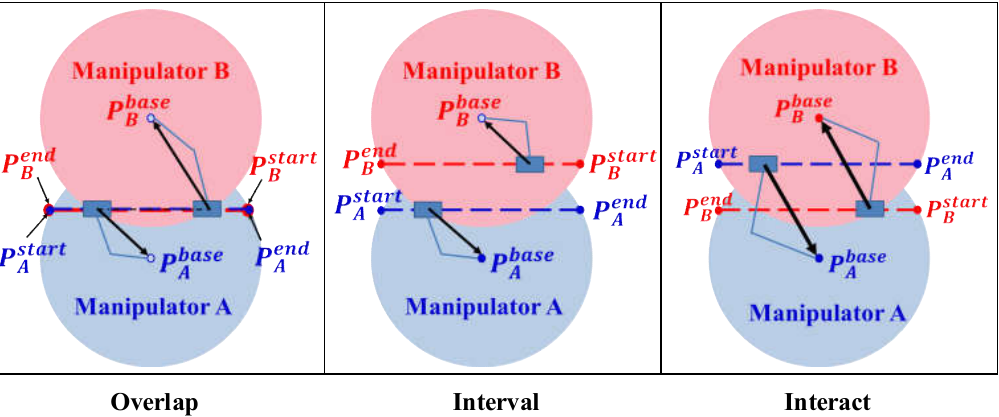
Figure 4. Three dual-manipulator coexistence scenarios. The blue dotted line represents the initial path of manipulator A, and the red dotted line represents the initial path of manipulator B. The blue area is the operation space of manipulator A, and the red area is the operation space of manipulator B. In the scenario of “Overlap”, the initial path of manipulator A is in the operation space of manipulator A and the initial path of manipulator B is in the operation space of manipulator B. In scenario “Interval”, the two initial paths overlap and the EEF points of the two manipulators should be driven back towards their points of departure. In scenario “Interact paths”, the avoidance strategy pushes the EEFs of the two manipulators into the working space of another manipulator, undoubtedly increasing the possibility of collision.